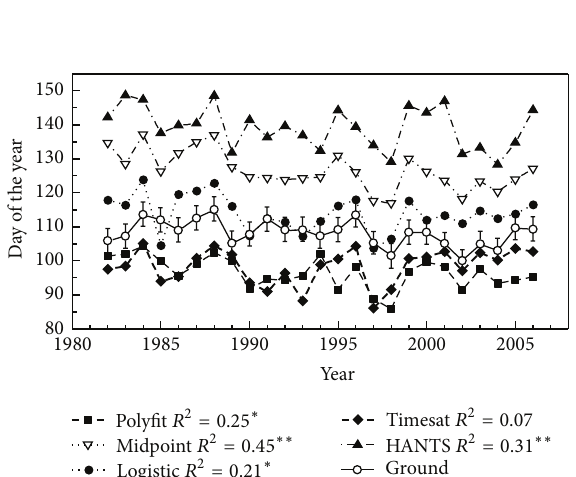
Figure 7: Comparison of five satellite-derived SOS measures and ground phenophases averaged over 12 sites from 1982 to 2006. Ground phenophases were first averaged to each site and then for all 12 sites across the region (note that the different sites have different sets of species). The missing ground observation data was interpolated by phenological models described by Ge et al. [8]. The error bar represents the uncertainty due to the interpolated data by models. Variances of ground phenophases explained by each SOS result ( 𝑅 2 ) are shown. ∗ 𝑃 < 0.05 , ∗∗ 𝑃 < 0.01